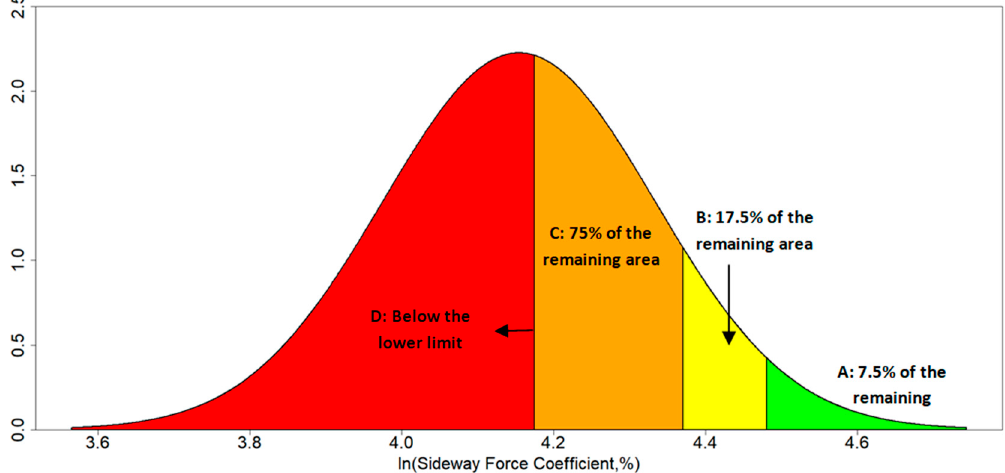
Figure 6. Probability density function of skid resistance.